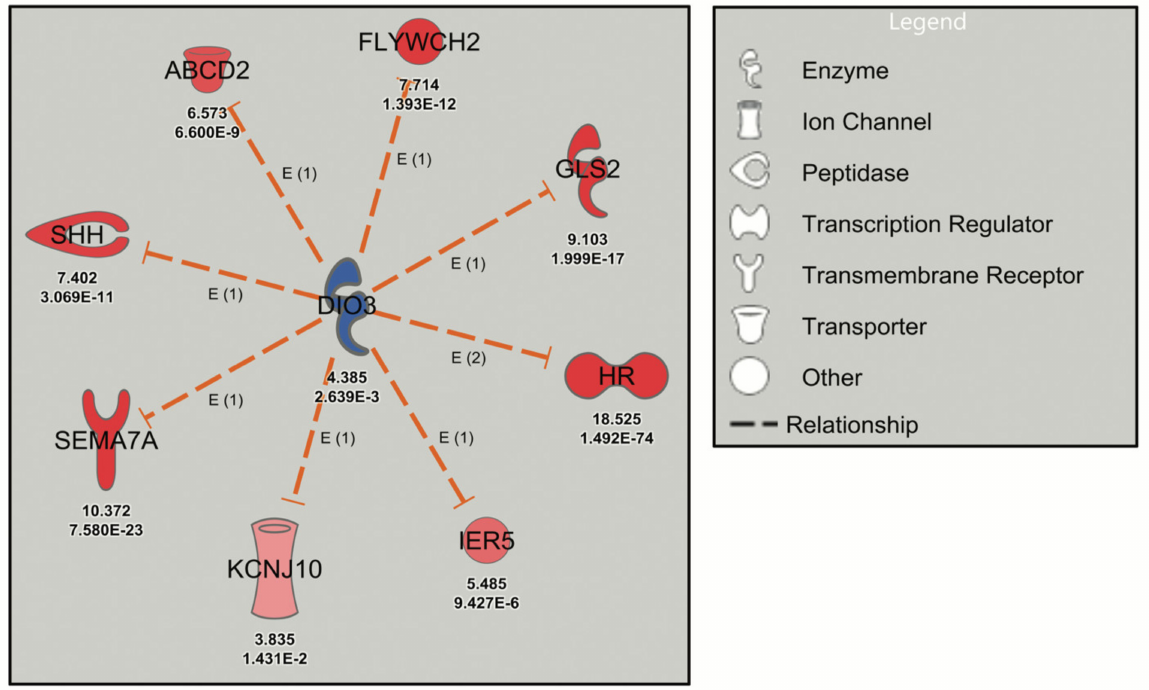
Figure 1. Robust URA network induced by levothyroxine treatment of mouse cerebrocortical cultures. Dashed orange lines signify activation (loss of inhibition) and red symbols signify upregulated genes with the Neuron Screen Z-score and adjusted p -value ( p -adj) (<0.05) appearing directly below each symbol. The upstream regulator DIO3 is blue, indicating downregulation based on the C4R drug screen